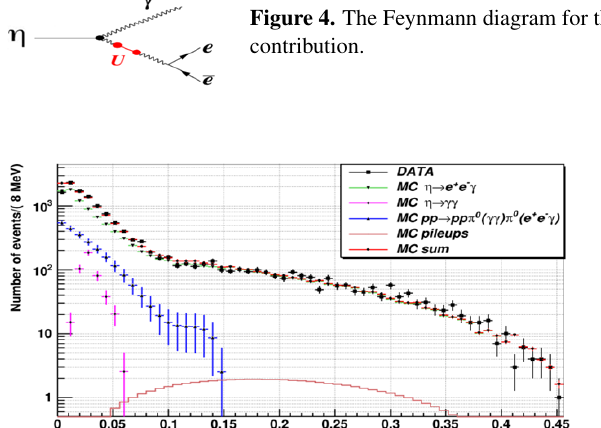
Figure 6. The upper limit (90% C.L.) on the dark photon-photon coupling parameter ( ε 2